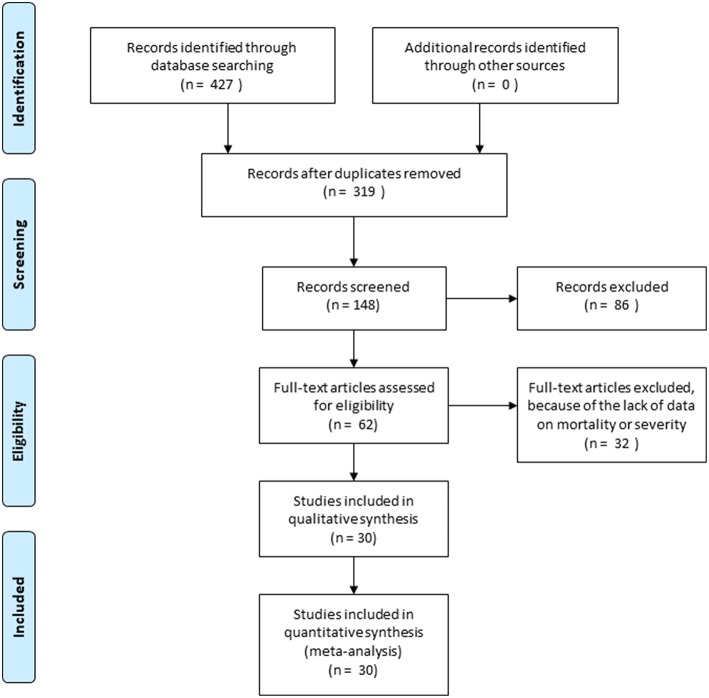
Flowchart of study selection.